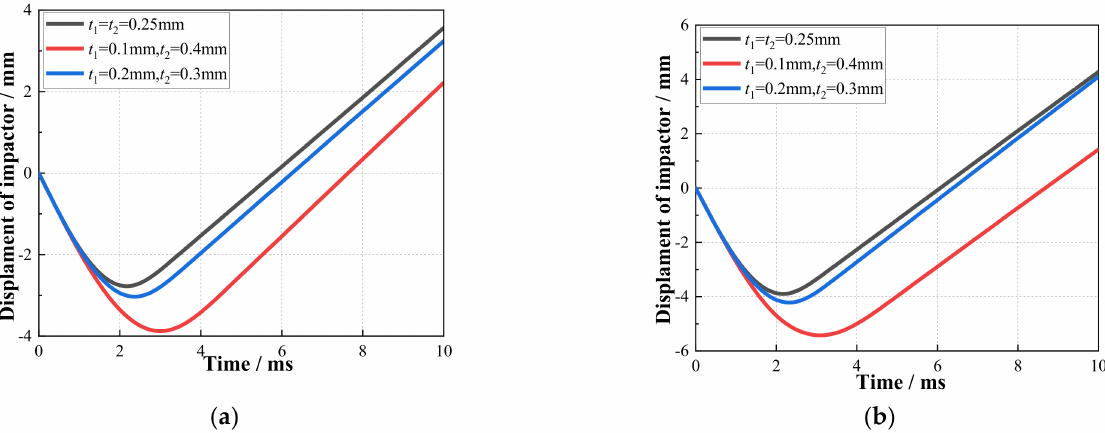
Figure 8. Displacement − Time curves of impactor with different core wall thicknesses under 5 J ( a ) and 10 J ( b ) impact energy.